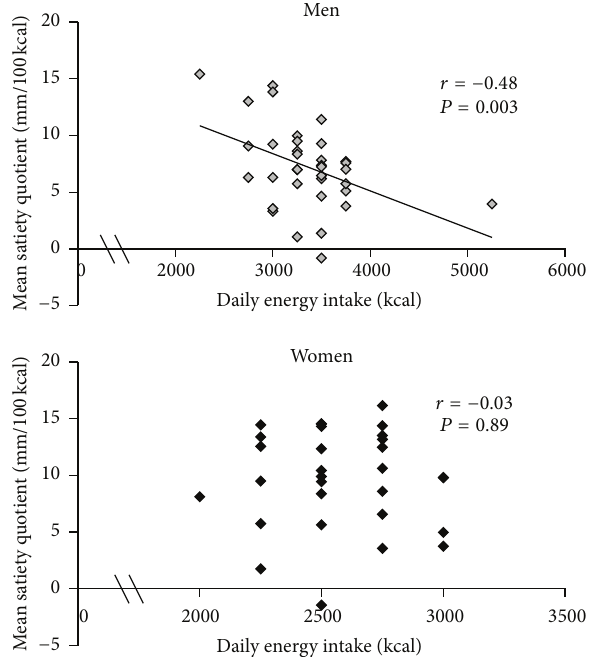
Figure 2: Pearson’s correlations between the mean satiety quotient for fullness sensation (i.e., the mean value for breakfast, lunch, and dinner) and daily energy intake in men and women during the Mediterranean diet feeding